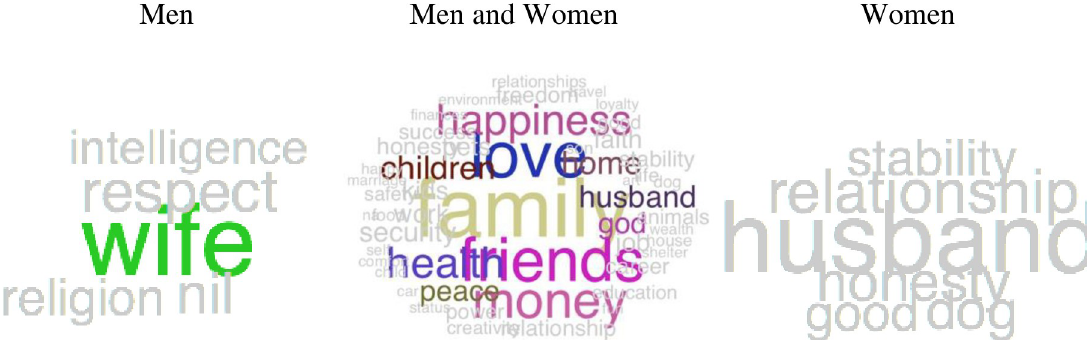
Fig 4. Word clouds describing what is important in life. Note . The women and men figure in the middle were created using the same method as in Fig 1 and based on word data answering the semantic questions “Please write five keywords describing the things that are most important to you in life”. The figure to the left also used this same method as in Fig 1, however, set 1 here consisted of words generated by women, and set 2 of words generated by men, whereas the figure to the right used the same data where set 1 and 2 were swapped. Colored words are significant following Bonferroni correction for multiple comparisons, whereas gray words are significant without corrections for multiple comparisons.